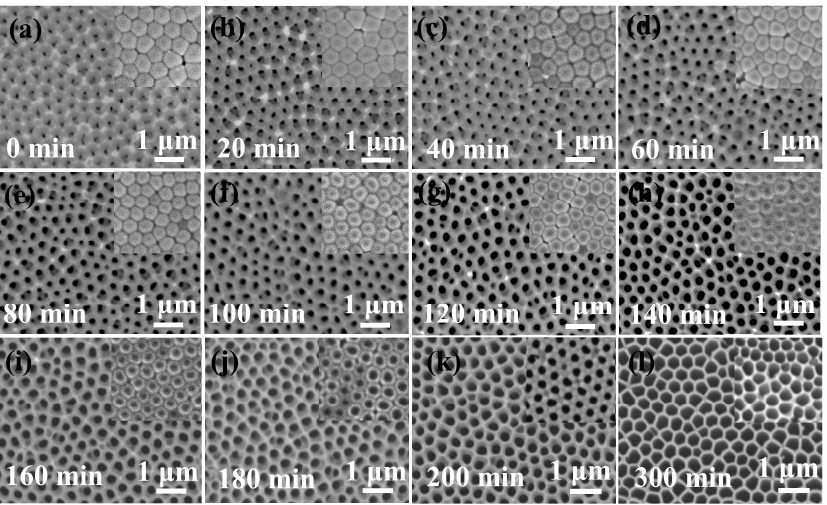
Figure 4. SEM images of the AAO film under different etching times. ( a–l ) SEM images of the PMMA/AAO composite film after different etching times.